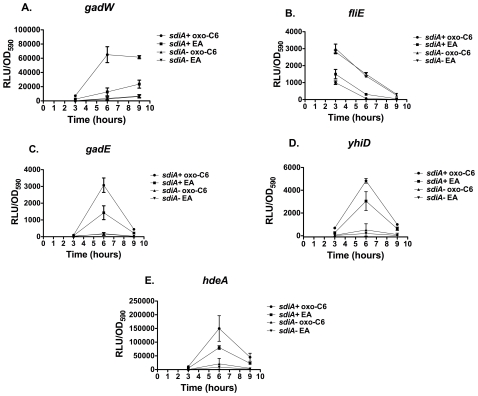
Regulation of AHL-regulated genes of E. coli K-12 and EHEC in liquid cultures at 37°C containing either 1 µM oxo-C6 or the solvent control, EA.Luminescence in relative light units (RLU) and OD590 were measured using a Wallac Victor2 1420 multimode plate reader at the time intervals noted. Each strain was assayed in triplicate and error bars represent standard deviation. A) AL4001/JLD800 (gadW), B) JLD604/JLD803(fliE), C) JLD605/JLD804 (gadE), D) JLD607/JLD806 (yhiD), E) JLD610 /JLD809 (hdeA).